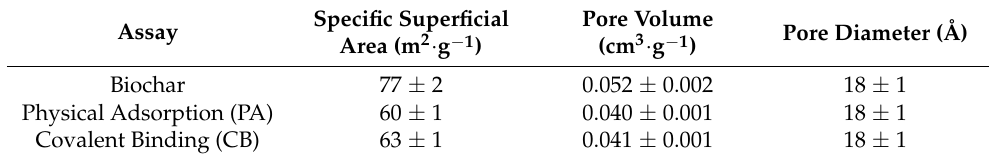
Table 2. Specific superficial area, volume and pore diameter of biochar and immobilized biocatalysts. Specific Superficial Pore Volume Assay Area (m 2 · g − 1 ) (cm 3 · g − 1 ) Biochar 0.052 ± 0.002 Physical Adsorption (PA) 60 ± 1 0.040 ± 0.001 Covalent Binding (CB) 63 ± 1 0.041 ± 0.001 18 ±